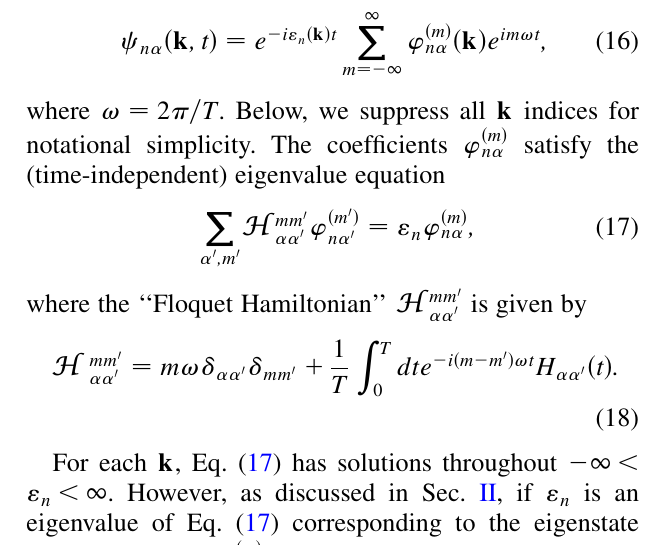
FIG. 3. Phases of the square lattice model in Sec. III. (a)–(c) Example Floquet spectra for each of the three phases, calculated in a strip geometry (unit cell 2 a ), with ¼ 0 : 5 (cid:1)=T and hopping amplitudes sublattice potential (cid:2) AB (a) J ¼ 0 : 5 (cid:1)=T , (b) J ¼ 1 : 5 (cid:1)=T , and (c) J ¼ 2 : 5 (cid:1)=T . The and W correctly yield the numbers of winding numbers W (cid:1) 0 edge states in the two gaps. The asymmetry in k k is due to the . breaking of inversion symmetry by the sublattice potential (cid:2) AB and W , (d) Phase diagram indicating the winding numbers W (cid:1) 0 calculated in the gaps at quasienergies 0 and (cid:1)=T , and Chern number C of the upper band. Note the existence of two topo- logically distinct phases with C ¼ 0